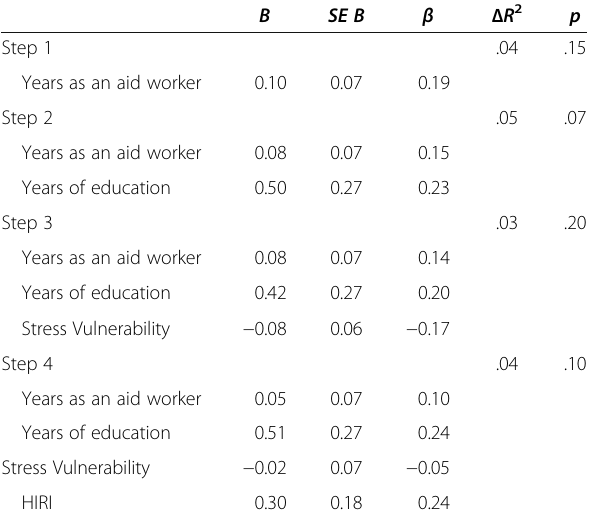
Post hoc correlations revealed that at time 1, the CICSE was positively correlated with adaptive engagement,